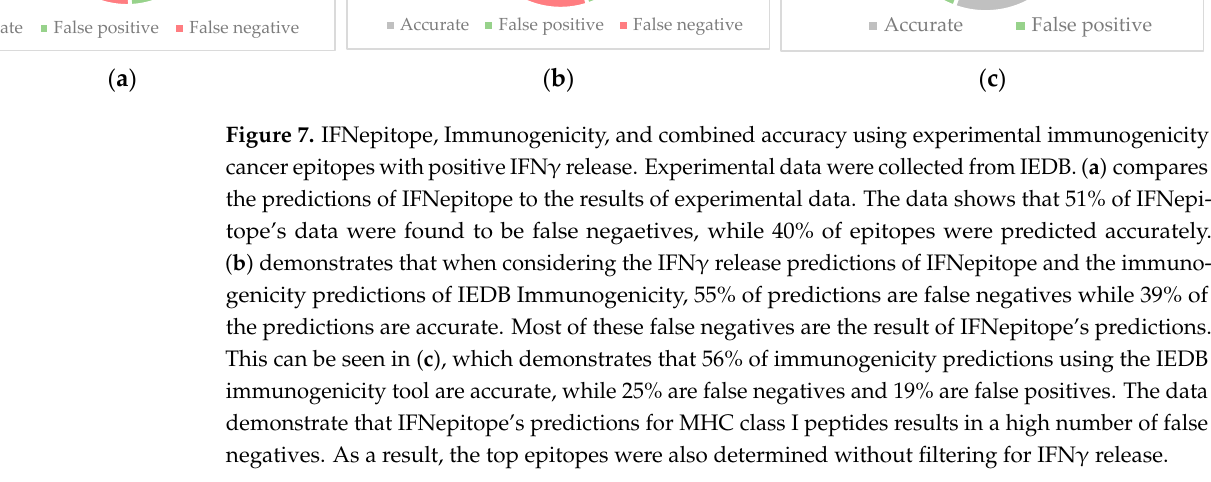
demonstrate that IFNepitope’s predictions for MHC class I peptides results in a high number of false negatives. As a result, the top epitopes were also determined without filtering for IFN γ